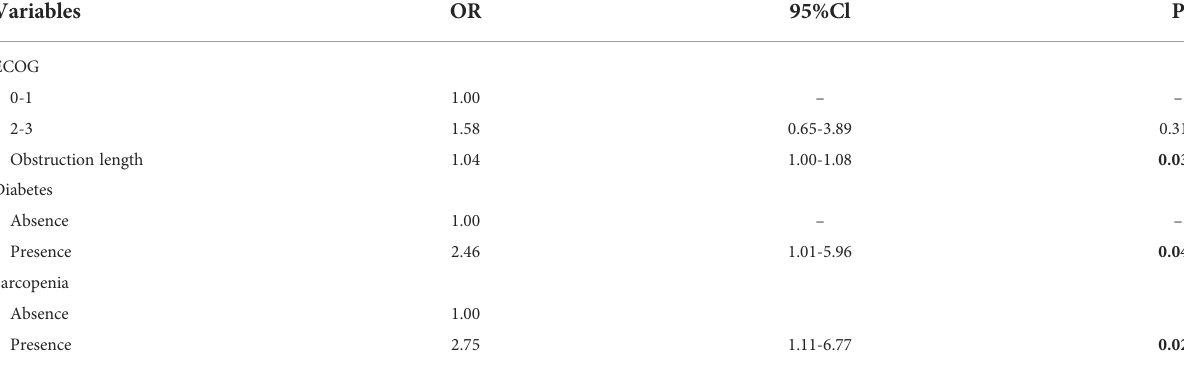
TABLE 3 Multivariate analysis of risk factors for EBI in patients after PTBS.